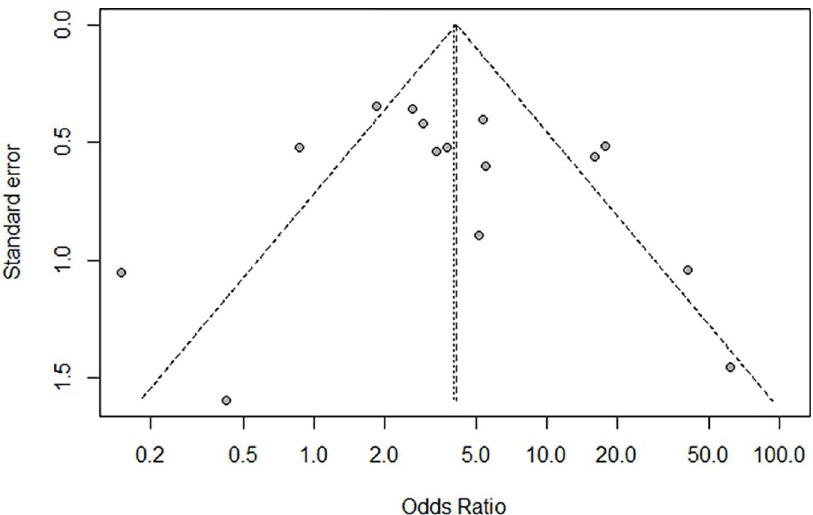
Fig 5. Begg’s funnel plot of DAPK promoter methylation associatedwith